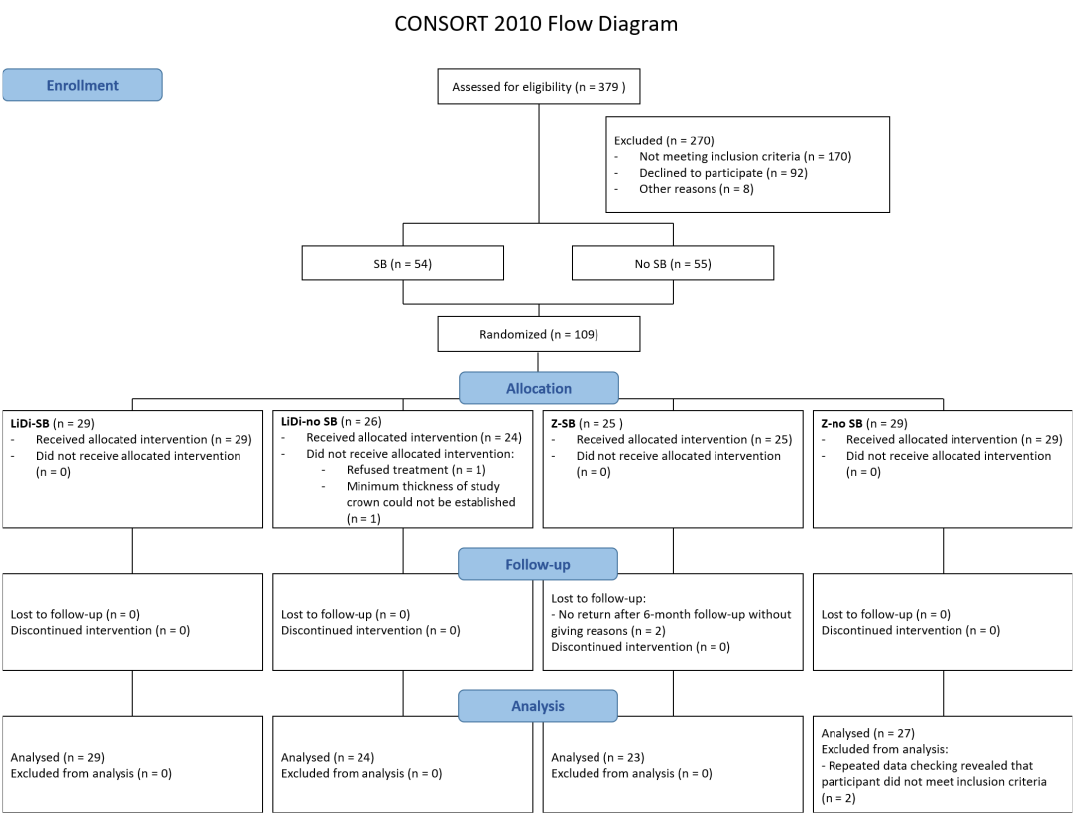
Figure 1. Participant flow diagram. LiDi: lithium disilicate, Z: zirconia, SB: sleep bruxism. The characteristics of the analyzed participants and their SCs are shown in Table 1.